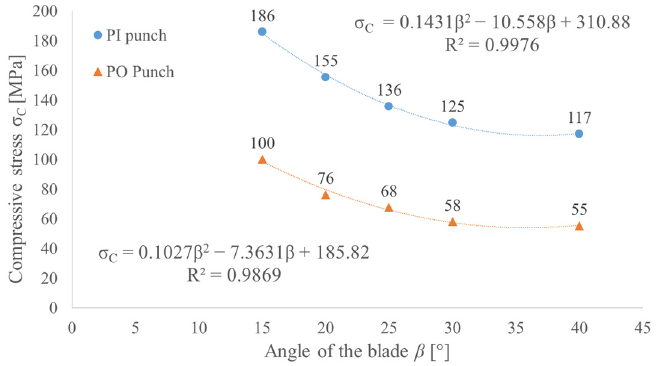
Figure 19. The influence of the angle of the blade β on the punch compressive stress σ C for both PI and PO punches with diameter d = 10 mm and height of the blade H = 2.65 mm for belt TFL10S.